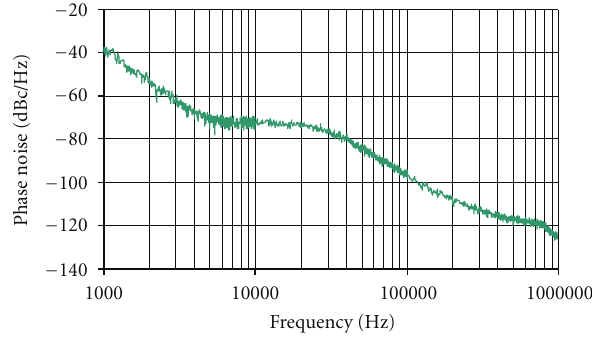
Figure 25: PN floor of the system.